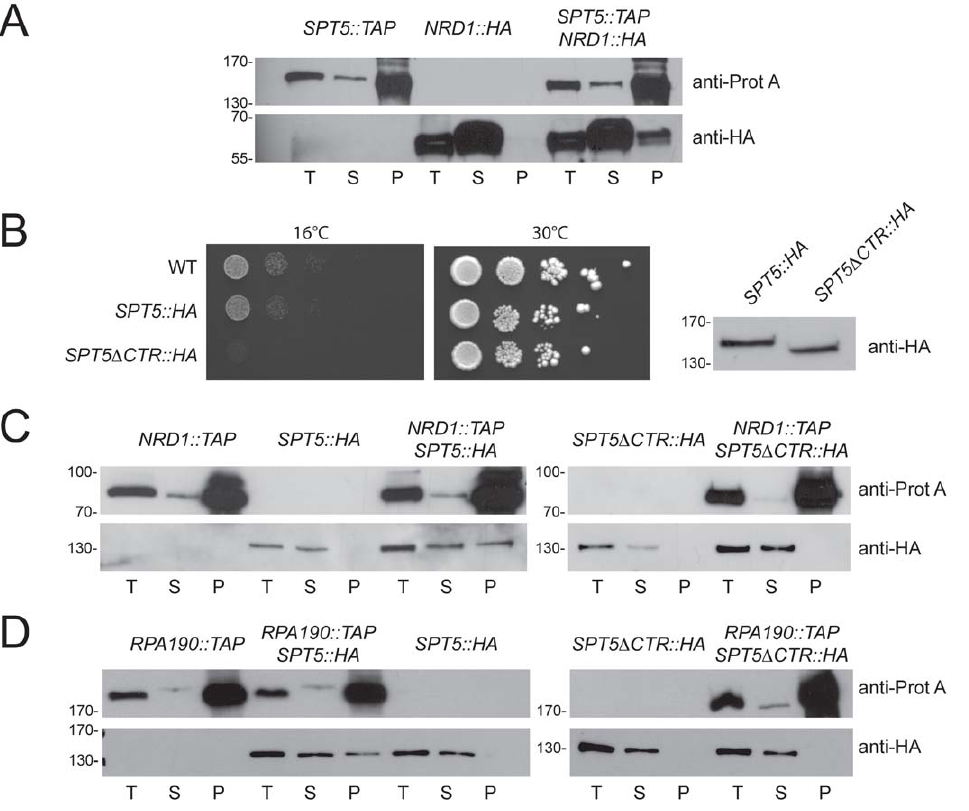
Figure 4. Spt5 interacts with Nrd1 and with the RNA Pol I through its conserved CTR. A, Spt5 interacts in vivo with Nrd1 Cells expressing functional Spt5-TAP and Nrd1-HA fusions were grown to mid-log phase in complete medium at 30 u C. Glass-bead lysates were used in affinity purification analysis with IgG-coated magnetic beads that specifically capture TAP-tagged constructs. Isogenic strains expressing Spt5-TAP or Nrd1- HA alone were used as controls. Fractions of the total (T), supernantant (S) and pellet (P) were loaded in a 1:1:20 ratio. Membranes were probed with peroxidase-anti-peroxidase raised in rabbit (recognizes the Protein A component of the TAP-tag fusions) or an anti-HA antibody. This experiment was repeated three times. B , Characterization of a SPT5 D CTR::HA construct. The precise deletion of the CTR of Spt5 in the genome of haploid cells resulted in a cold-sensitive phenotype for growth (left, cells were incubated for 5 d at 16 u C, 2 d at 30 u C), and the expression of a protein reduced in length by the expected size (right). The presence of an HA-tag at the carboxyl end of the construct, which did not affect functionality of the full-length construct (see SPT5::HA at 30 u C), allowed Western-blot detection with an anti-HA antibody. C , The interaction between Spt5 and Nrd1 requires the CTR domain of Spt5. Cells expressing functional Nrd1-TAP and either a full-length Spt5-HA fusion, or a Spt5-HA construct precisely truncated for its entire CTR, were used as described in panel A. This experiment was repeated two times. D, The interaction between Spt5 and RNA Pol I requires the CTR domain of Spt5. Cells expressing functional Rpa190-TAP and either a full-length Spt5-HA fusion, or a Spt5-HA construct truncated for its CTR were used as described in panel A. This experiment was repeated three times. To the left of each western blot panel, molecular weight markers (in kDa).